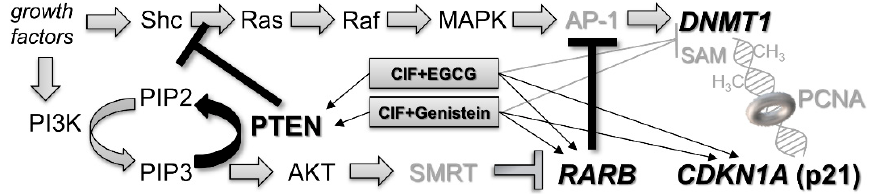
Figure 6. The potential repressive effects of the tested combinatorial exposures of ClF with EGCG or genistein on modulation of DNMT1 transcription and/or activity in breast cancer cells. Implications of RARB and PTEN-mediated negative regulation of intracellular oncogenic signaling pathways, including MAPK/AP-1 and PI3K/AKT. A competition of CDKN1A (p21) with DNMT1 for the same binding site on PCNA. Shc, SH2-containing collagen-related proteins; MAPK, mitogen-activated protein kinase; AP-1, activator protein 1; PI3K, phosphatidylinositol-4,5-bisphosphate 3-kinase; PIP2, phosphatidylinositol (4,5)-bisphosphate; PIP3, phosphatidylinositol (3,4,5)-trisphosphate; SMRT, thyroid-, retinoic-acid-receptor-associated corepressor; SAM, S -adenosyl- L -methionine; PCNA, proliferating cell nuclear antigen.